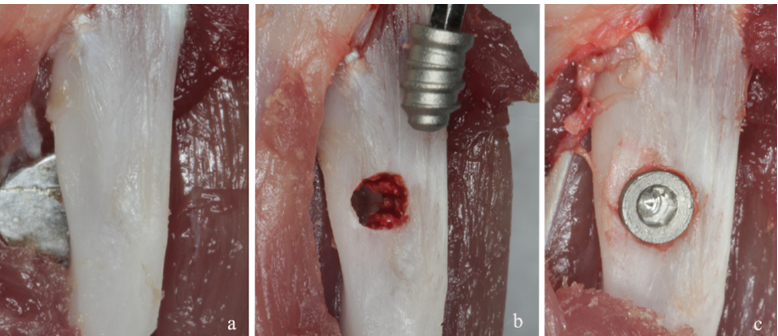
Figure 1. ( a ) Surgical exposition of the bone surface of the tibiae by rhombus dissection. ( b ) Bi- cortically prepared implant bed and placement of titanium implant into the tibia. ( c ) Implant was completely inserted when all screw threads had fixed into the bone cortex. completely inserted when all screw threads had fixed into the bone